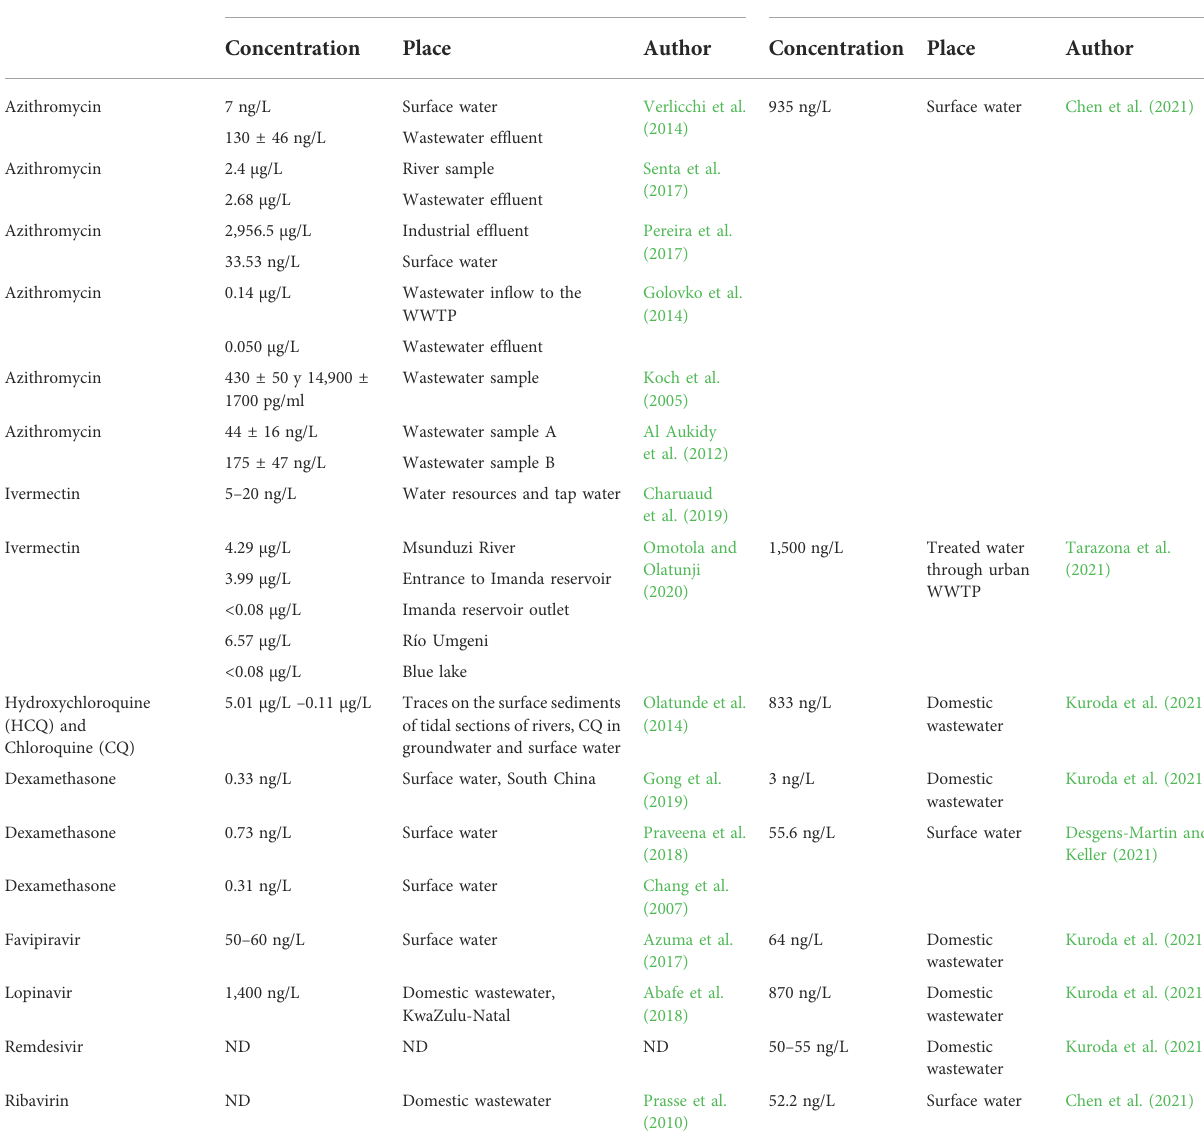
TABLE 2 Presence in the environment of pharmaceutical residues used to treat COVID 19.